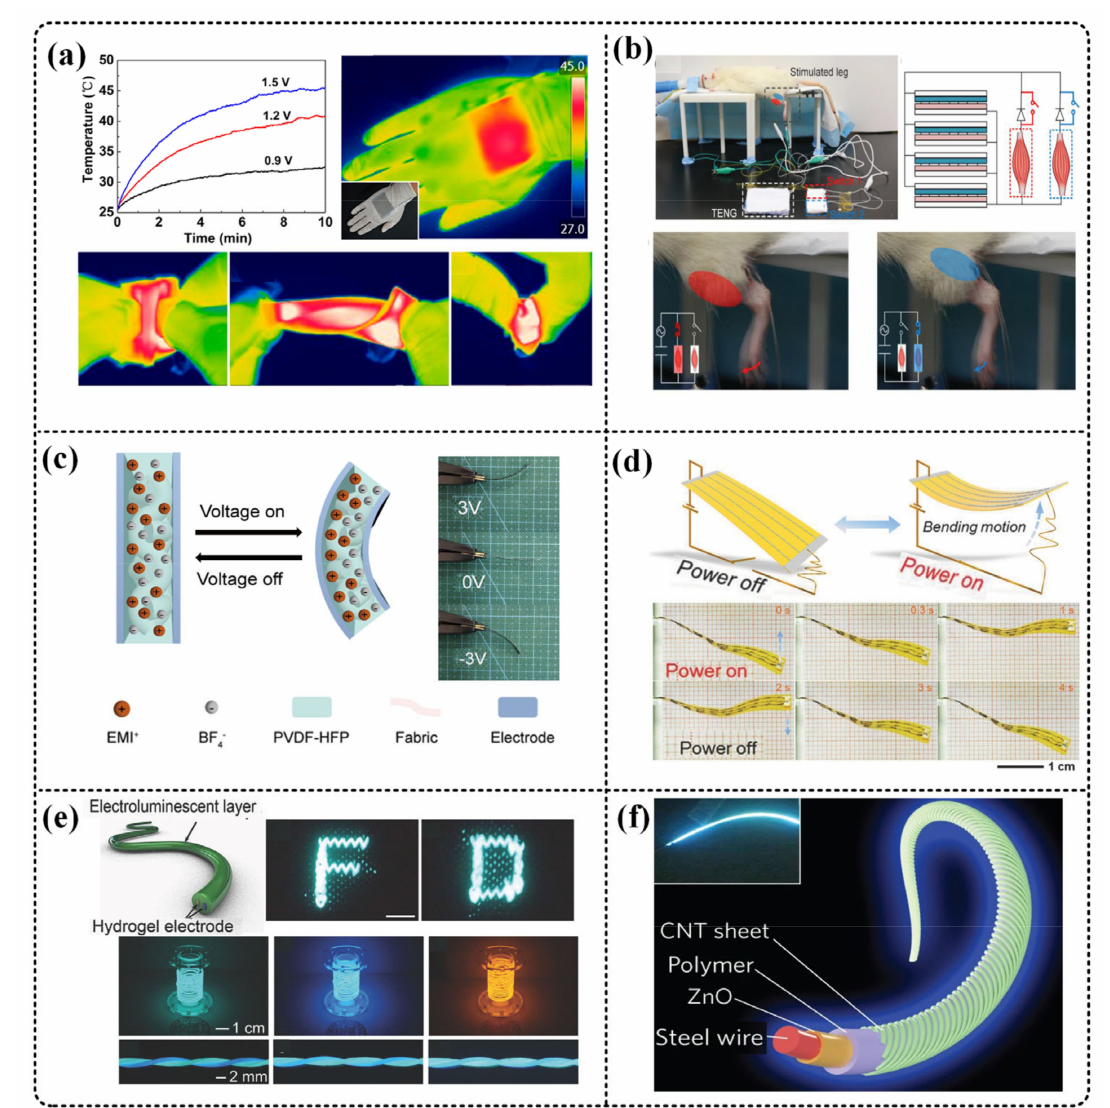
Figure 6. T-TENG is used to drive the actuators. ( a ) Guo et al. coated fluoroalkylsilane (FAS), polydimethylsiloxane (PDMS), and silver nanowires (AgNWs) on nylon cloth by dip coating to obtain a fabric that can be heated. Reproduced with permission from American Chemical Society (2016) [39]. ( b ) He et al. proposed a diode-enhanced T-TENG and used this TENG to stimulate the tibialis anterior and gastrocnemius muscles of anesthetized mice. Reproduced with permission from Wiley (2019) [33]. ( c ) Wu et al. developed a fabric actuator based on carbonized products and PEDOT:PSS electrodes. [94]. ( d ) Chen et al. woven conductive fibers into polymer tapes to prepare actuators, using spring-like CNT fibers to prepare actuators. Reproduced with permission from Wiley (2015) [95]. ( e ) Zhang et al. also produced a super stretchable luminescent fiber. Reproduced with permission from Wiley (2018) [96]. ( f ) Zhang et al. developed a color-tunable fibrous polymer light-emitting device using a coaxial structure. Reproduced with permission from Springer Nature (2015)